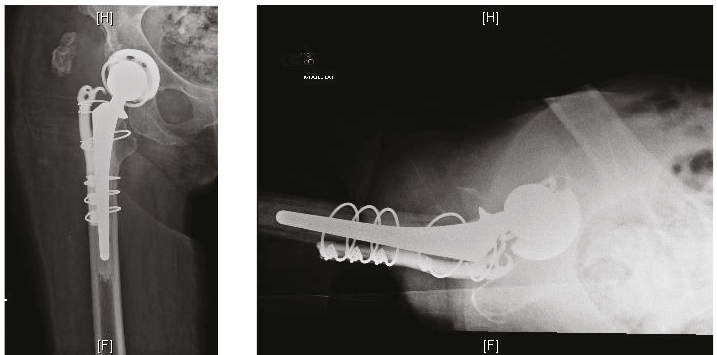
Figure 6: Anteroposterior (AP) and lateral right hip radiographs, seven months status post revision total hip arthroplasty with greater trochanter escape from hook plate.